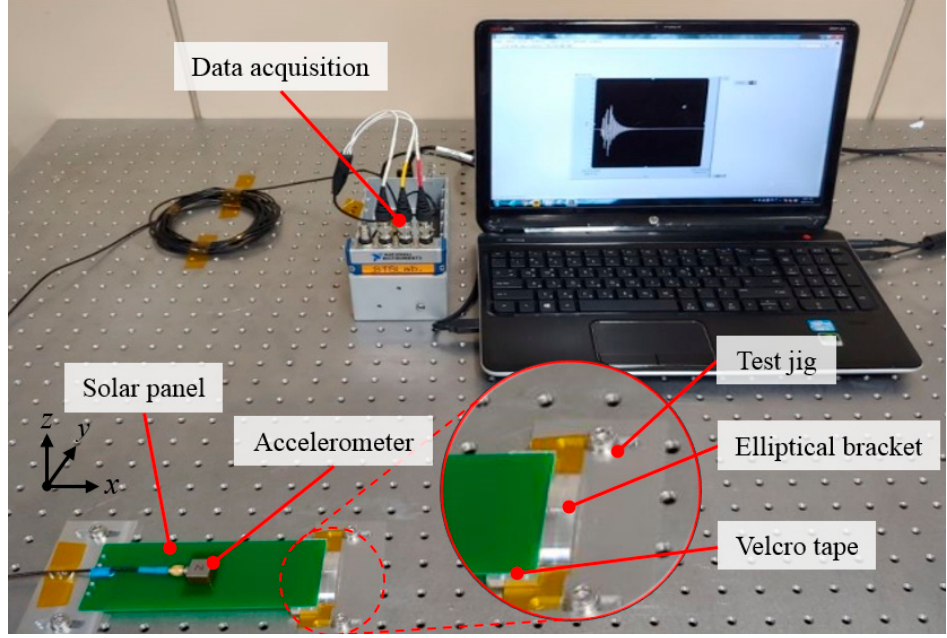
Figure 7. Free vibration test setup configuration of the solar panel employing the Velcro tape-type HRM.